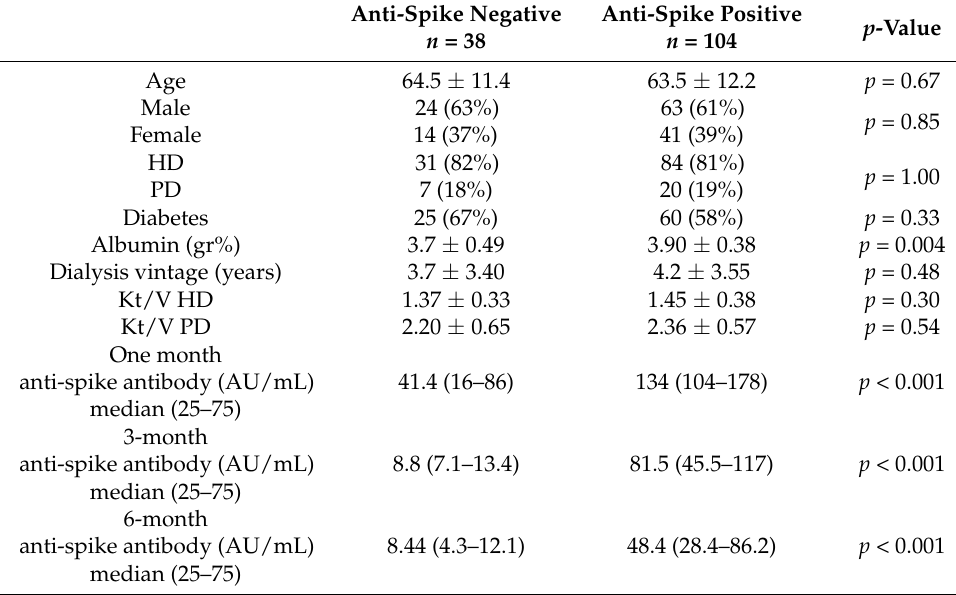
Table 3. Anti-spike antibody status in vaccinated dialysis patients at six